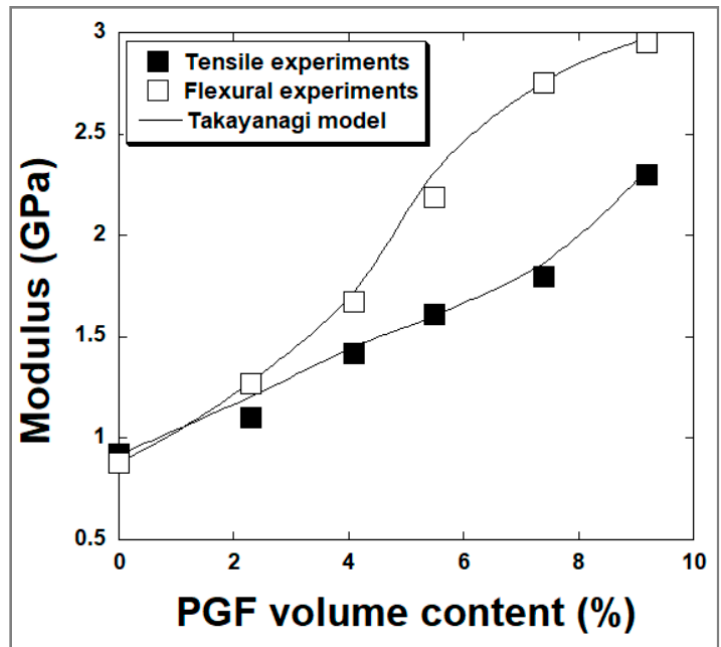
Figure 10. Fitting by Takayanagi model on the evolution of the modulus of sPGF/polyester-based composites vs. filler volume fraction.